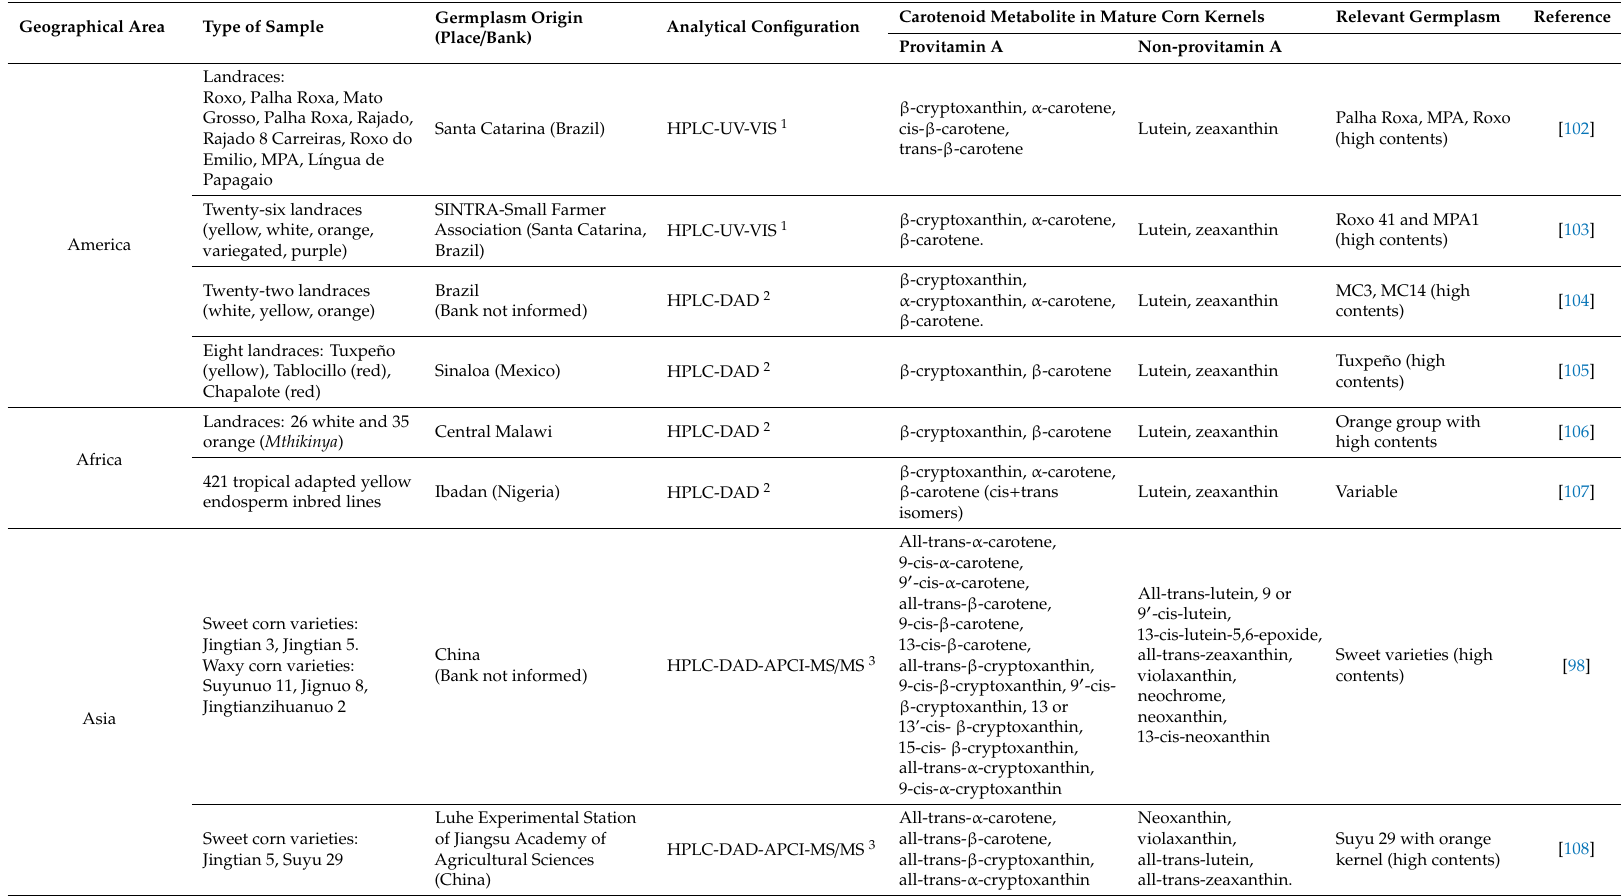
Table 4. Targeted metabolomics for the characterization of carotenoid compounds in worldwide corn